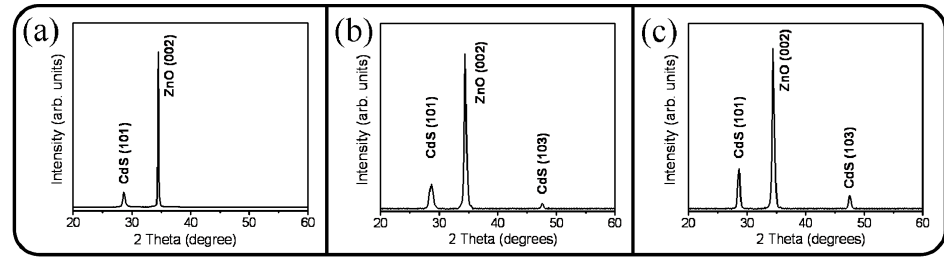
Figure 2. XRD patterns: ( a ) ZnO-CdS (5 nm) nanorods; ( b ) ZnO-CdS (20 nm) nanorods; ( c ) ZnO-CdS nanorods annealed.